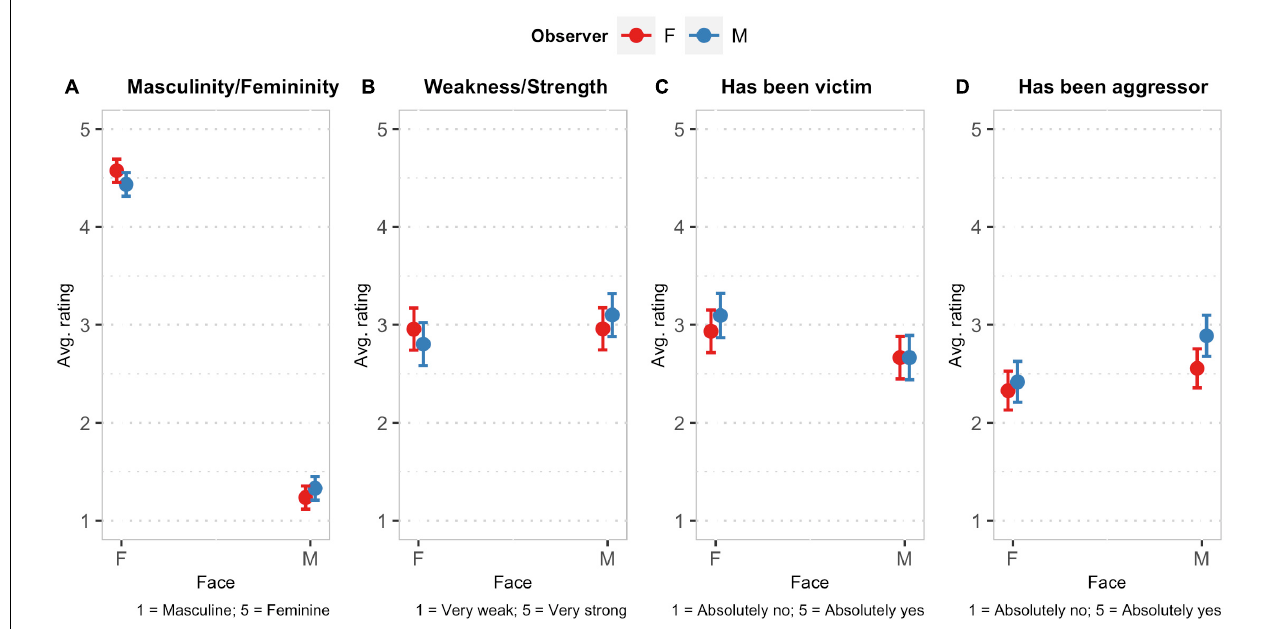
FIGURE 2 | Marginal means of the ratings of the faces concerning (A) masculinity/femininity, (B) weakness/strength, (C) having been a victim of acts of aggression in the past, and (D) having been perpetrators of acts of aggression in the past, as a function of the gender of participants and of the gender of the people represented in the faces. Error bars are 95% confidence intervals of the means, estimated from the fitted LMMs.